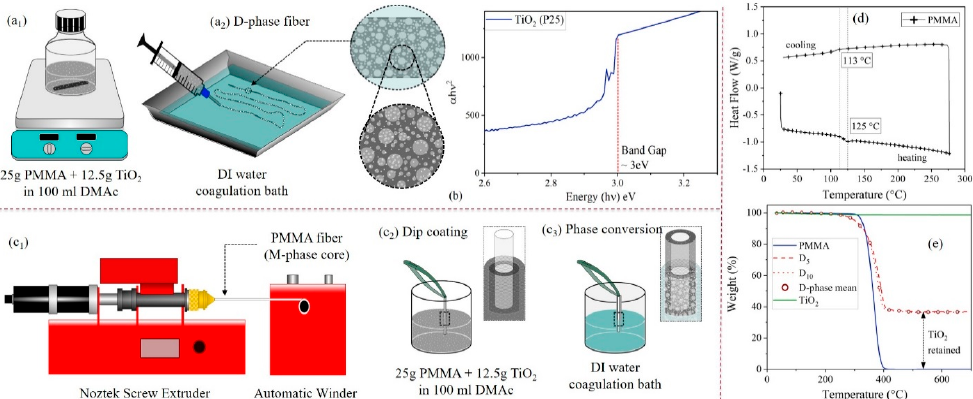
Figure 1. Schematic of the fabrication procedures for ( a 1 , a 2 ) preparing D-phase containing the ( b ) TiO 2 with a bandgap of 3 ev (Tauc plot) and ( c 1 ) PMMA fiber extrusion, ( c 2 ) dip coating of extruded PMMA fiber and ( c 3 ) phase conversion for M-phase fibers. ( d ) Di ff erential scanning calorimetry (DSC) of polymethyl methacrylate (PMMA) raw material. ( e ) Back-to-back thermogravimetric analysis (TGA) conducted to quantify TiO 2 retention after wet phase